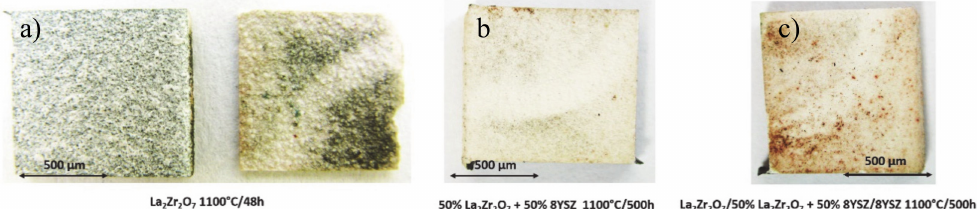
Figure 9. Top view of TBC specimens after the end of the oxidation test: ( a ) monolayered La 2 Zr 2 O 7 , ( b ) composite 50% La 2 Zr 2 O 7 + 50% 8YSZ, and ( c ) DCL La 2 Zr 2 O 7 / 50% La 2 Zr 2 O 7 + 50% 8YSZ / 8YSZ.